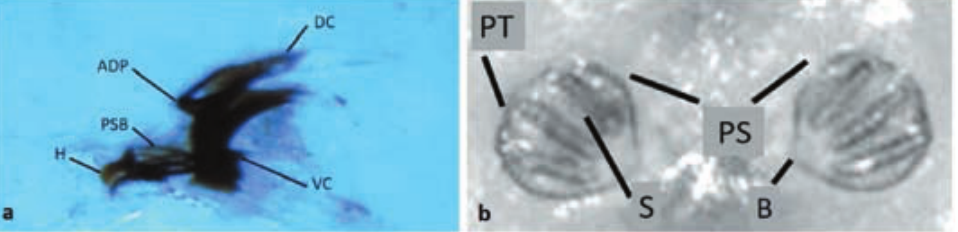
Fig 2 . a. Cephalopharyngeal skeleton of 3 rd Instar showing hook(H), parastomal bar(PSB), anterior dorsal process(ADP), dorsal cornua(DC),ventral cornua(VC) b. Posterior spiracles(PS)of 3 rd Instar showing completely separated peritreme(PT), 3 diagonally placed slits(S),medially placed button(B)